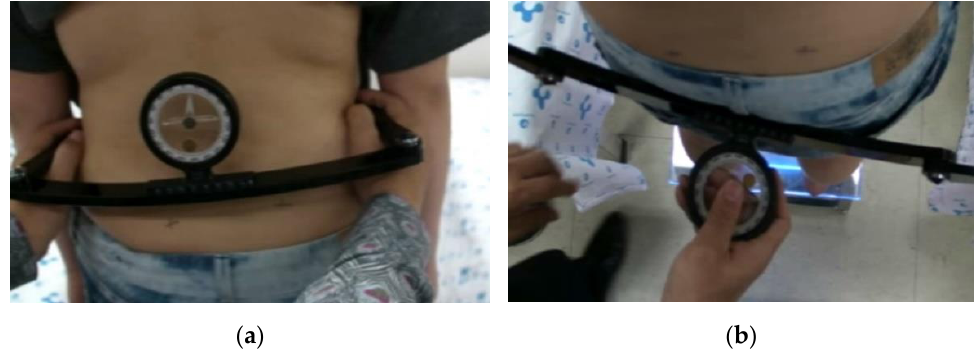
Figure 4. Measurement of pelvic asymmetry in ( a ) the coronal plane and ( b ) in the transverse plane.